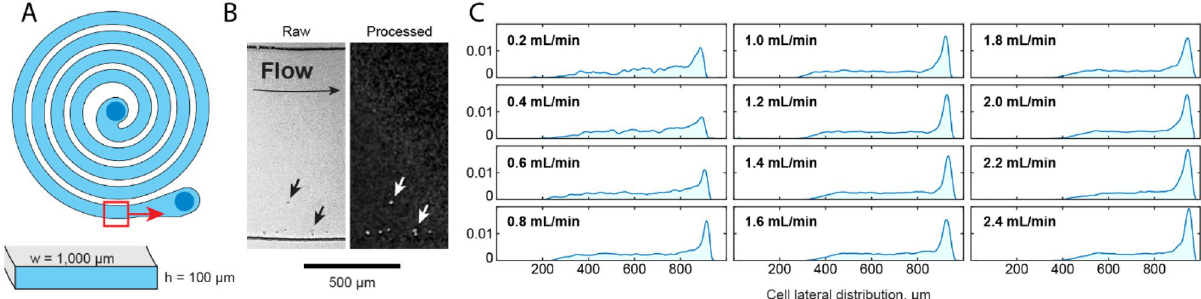
Figure 4. Inertio-elastic cell focusing in a rigid and high aspect ratio spiral microchannel. ( a ) Schematic of microchannel geometry Inlet is at center of spiral. ( b ) Representative raw and processed images of Jurkat cells under flow in a viscoelastic suspension of hyaluronic acid. ( c ) Focusing performance quantified by lateral distributions of cells from inner (convex) to outer (concave) wall, at increasing flow